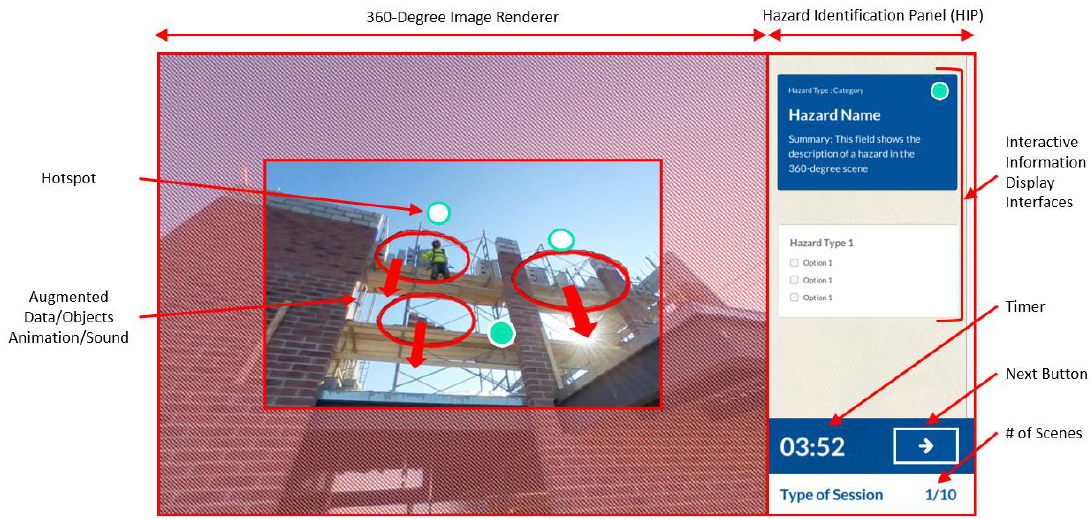
Figure 5. PARS Platform Application Graphical User Interface.